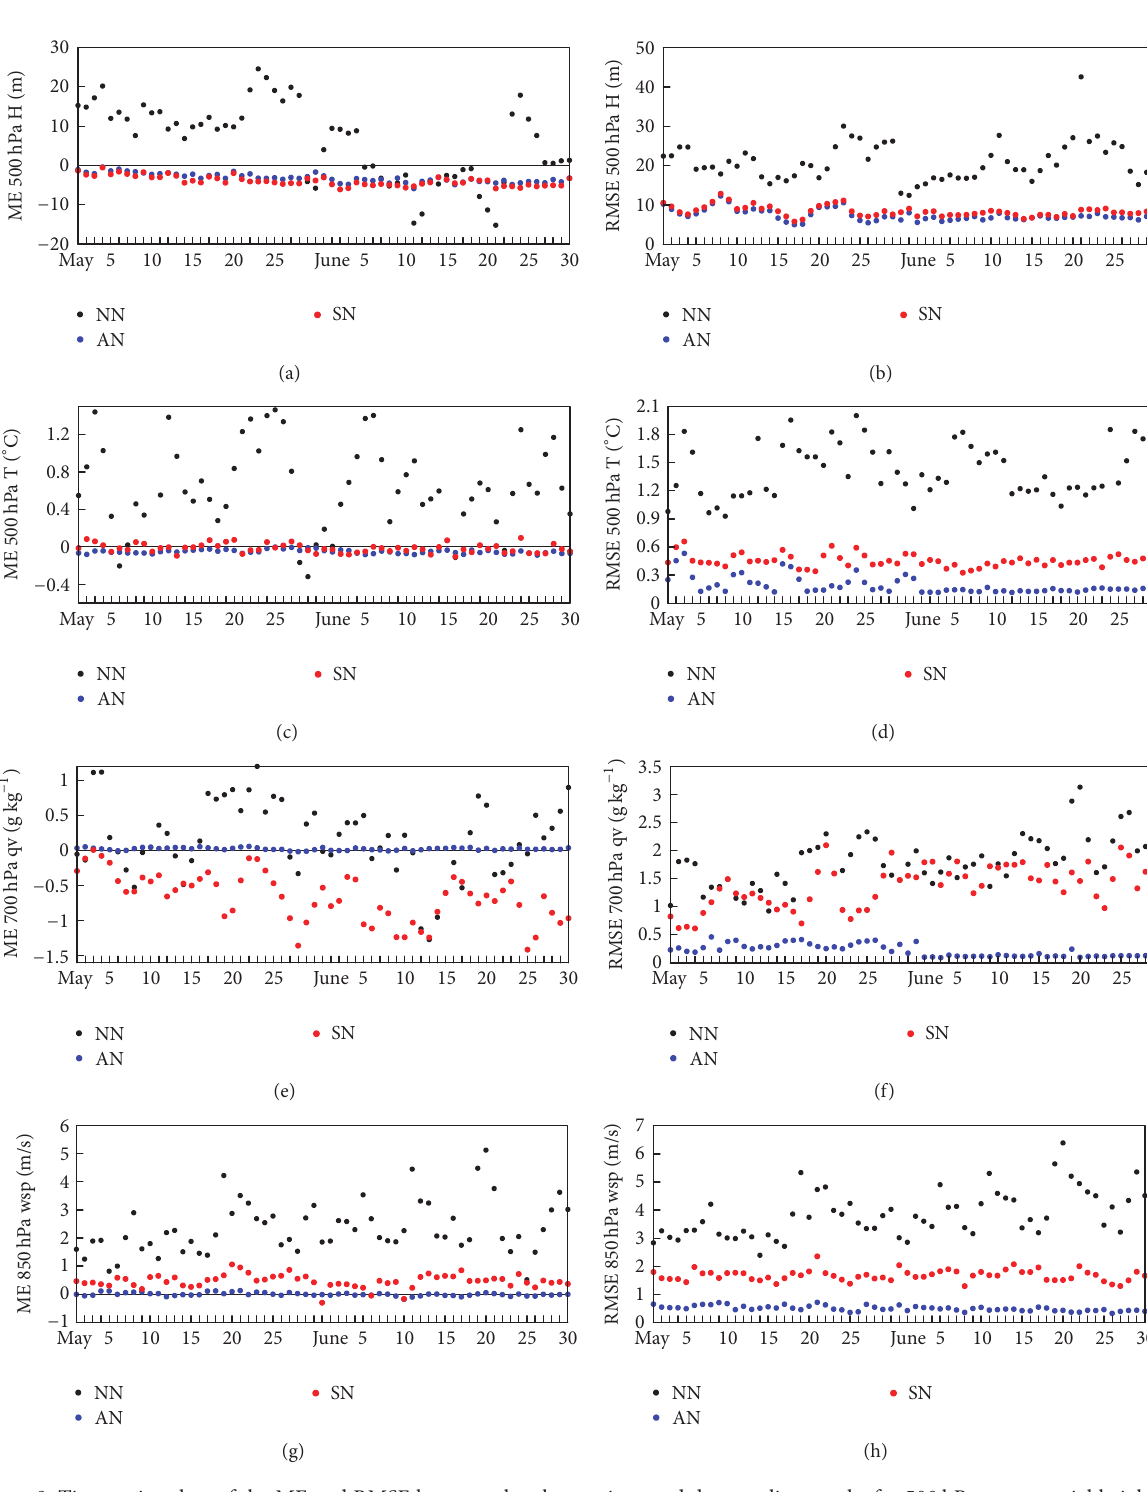
Figure 9: Time series plots of the ME and RMSE between the observations and downscaling results for 500 hPa geopotential height (a, b) and temperature (c, d), 700 hPa water vapor mixing ratio (e, f), and 850 hPa wind speed (g, h) for May and June